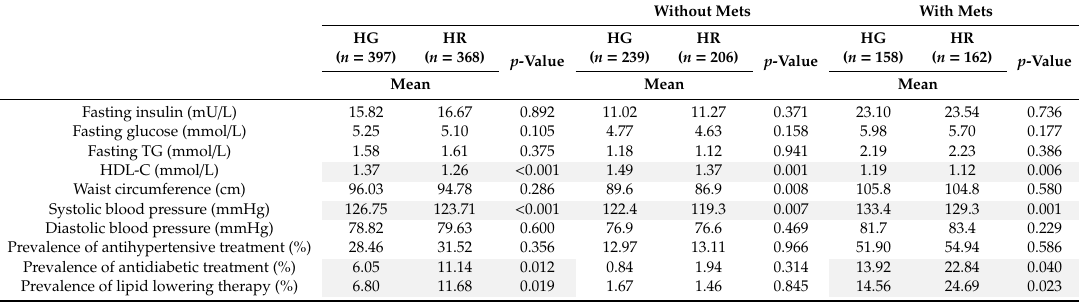
Significant di ff erences are highlighted in grey.